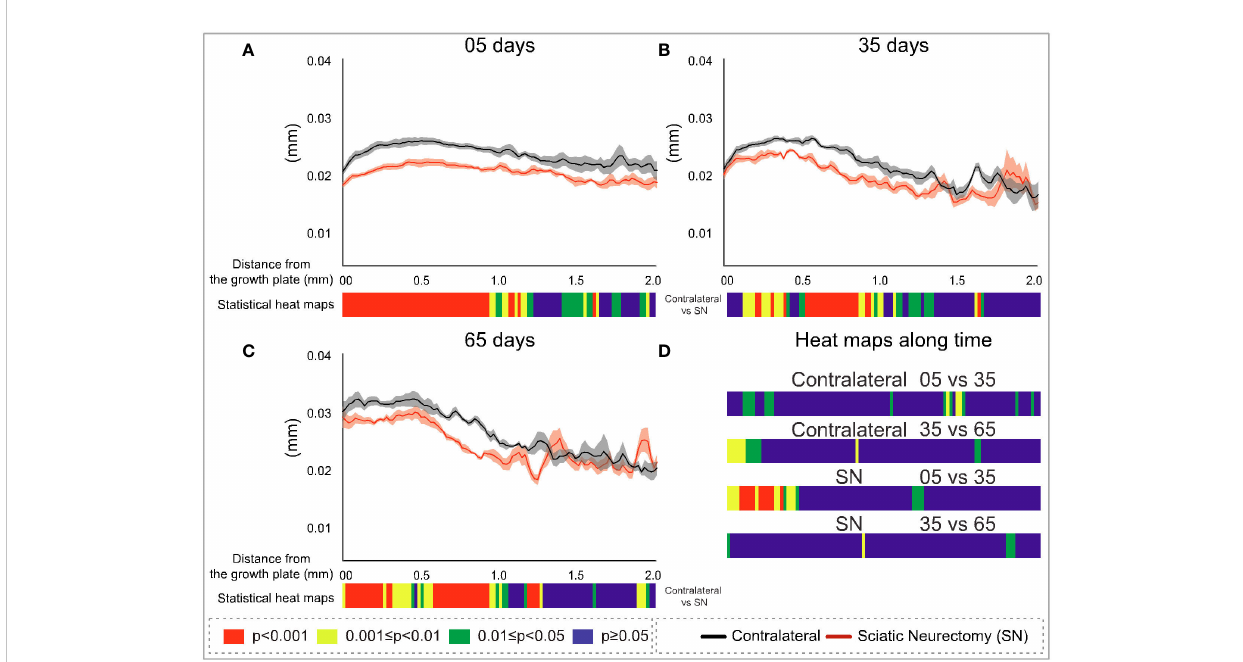
FIGURE 8 Cross-sectional (2D) trabecular thickness (Tb.Th) with distance from the growth plate in study B in sciatic-neurectomised (SN, red) and contralateral tibias (black) at (A) 5 days, (B) 35 days, and (C) 65 days after surgery. For all pro fi les, the SEM ranges are shown graphically. In each of the three charts, the colour bar below shows the p -value of the signi fi cance of difference (chi-square) by cross-sectional plane (downstream distance) between the left contralateral and right SN tibias. Additional colour bars (D) show if changes occurred earlier or later in the study based on the signi fi cance of difference of the cross-sectional Tb.Th with downstream distance in time-based comparisons spanning early and late time intervals for SN and contralateral control